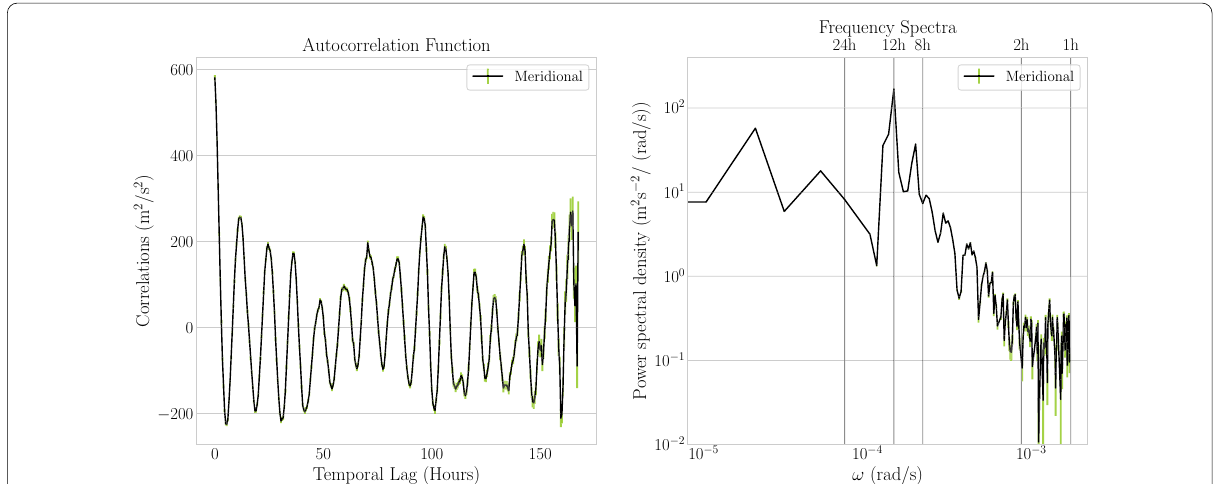
Fig. 3 Autocorrelation function, and frequency spectra of the meridional wind component derived using the WCFI method. The autocorrelation function was estimated by averaging over a range of 87 to 93 km in altitude with 1800 s (30 min) temporal lag, 50 km horizontal lag and 1 km vertical lag resolutions